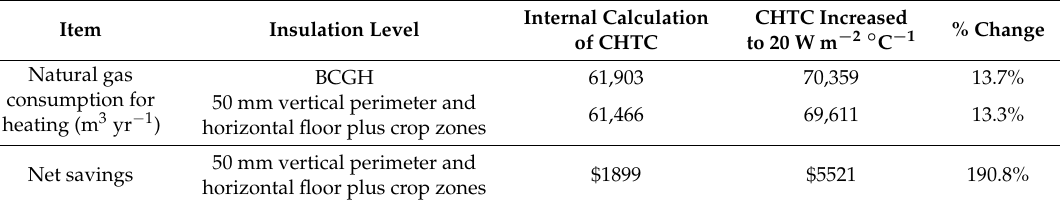
Table 5. Effect of ground surface CHTC for the greenhouse with a concrete